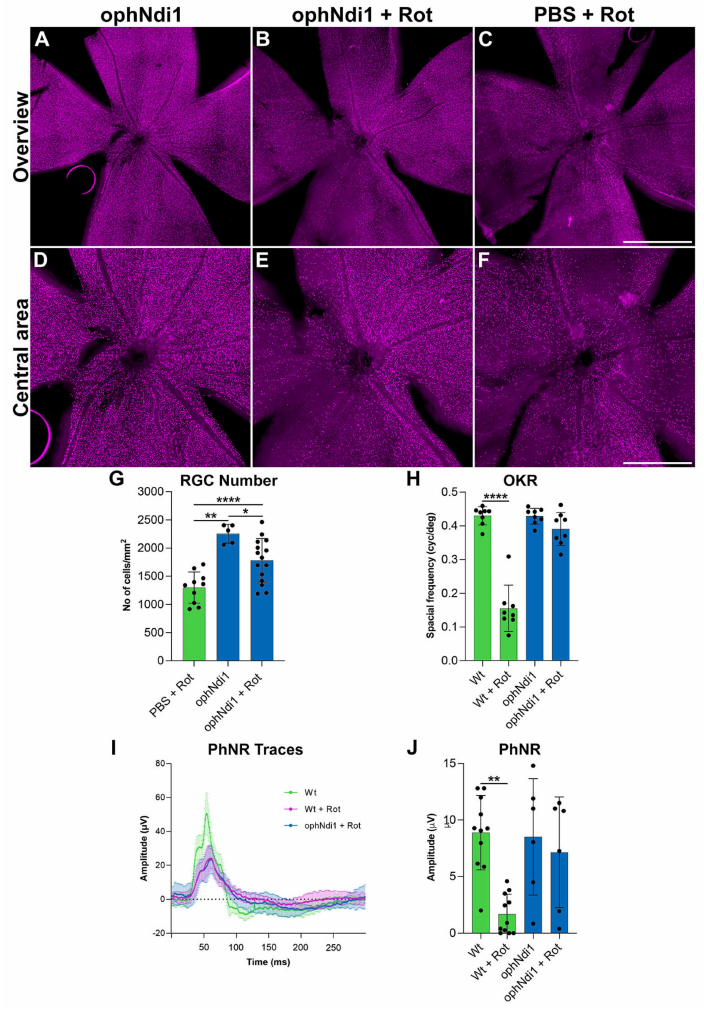
Figure 2. Analysis of AAV-ophNdi1-treated mice following rotenone insult. To establish the func- tional effects of AAV-ophNdi1 in vivo, adult 129 S2/SvHsd wild type mice were injected intravitreally (IVT) with 3 × 10 9 vg/eye AAV-ophNdi1 (blue bars) or PBS (green bars), plus 1 × 10 8 AAV-EGFP, and 1.5 mM rotenone was administered IVT six weeks later, as indicated. Bar charts represent: ( H )